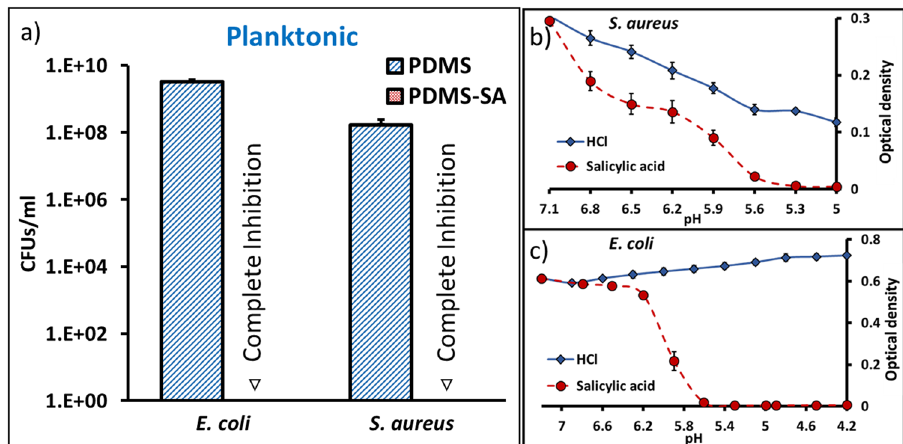
Fig. 7 Inhibition of planktonic E. coli and S. aureus after 24 h of incubation. a Antimicrobial activity of PDMS-SA compared to PDMS control samples, inverted triangles indicate complete inhibition at inoculum 10 4 CFU/ml (additional data for higher inoculum is presented in Supplementary Information); b , c Deconvolution of pH effects on bacterial growth for b E. coli and c S. aureus incubated in growth medium with increasing concentrations of hydrochloric acid (HCl) or SA, showing that the minimum inhibitory concentration for SA is reached at pH values where bacterial growth is still and Supplementary Fig. SI4.1 for additional bacterial growth curves).